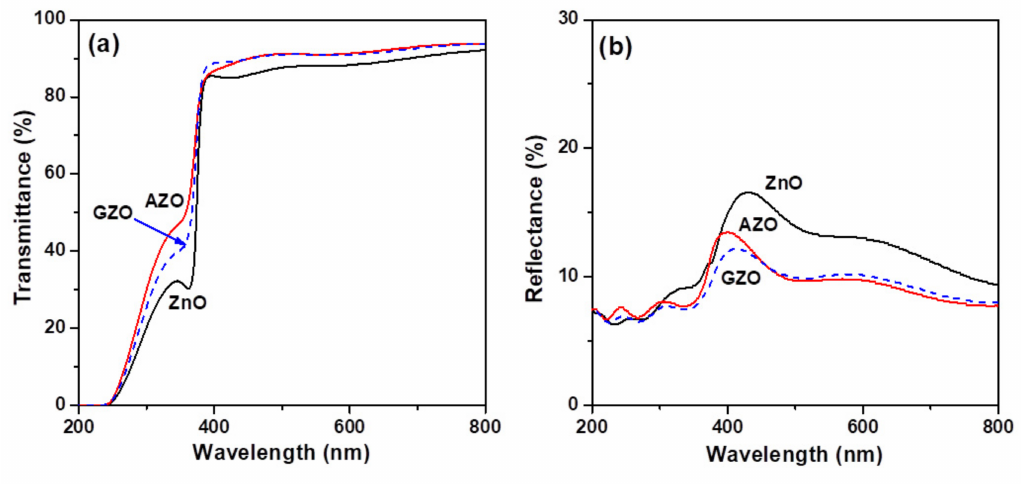
Figure 5. ( a ) Optical transmittance spectra and ( b ) optical reflection spectra of ZnO, AZO, and GZO thin